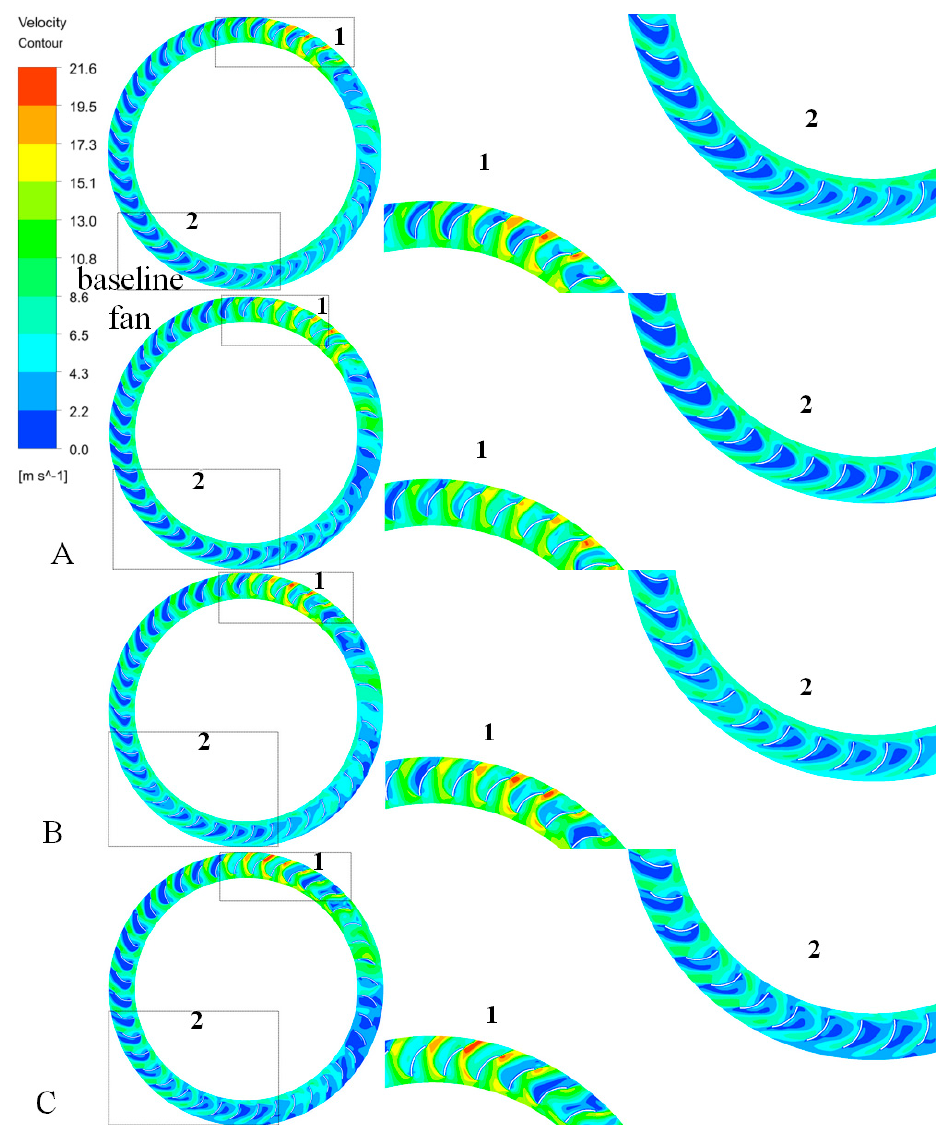
Figure 13. Magnitude of absolute velocity of the impeller for the z = 35 mm plane at a high flow rate Q / Q n = 1.760: ( A ) model-A; ( B ) model-B; ( C )